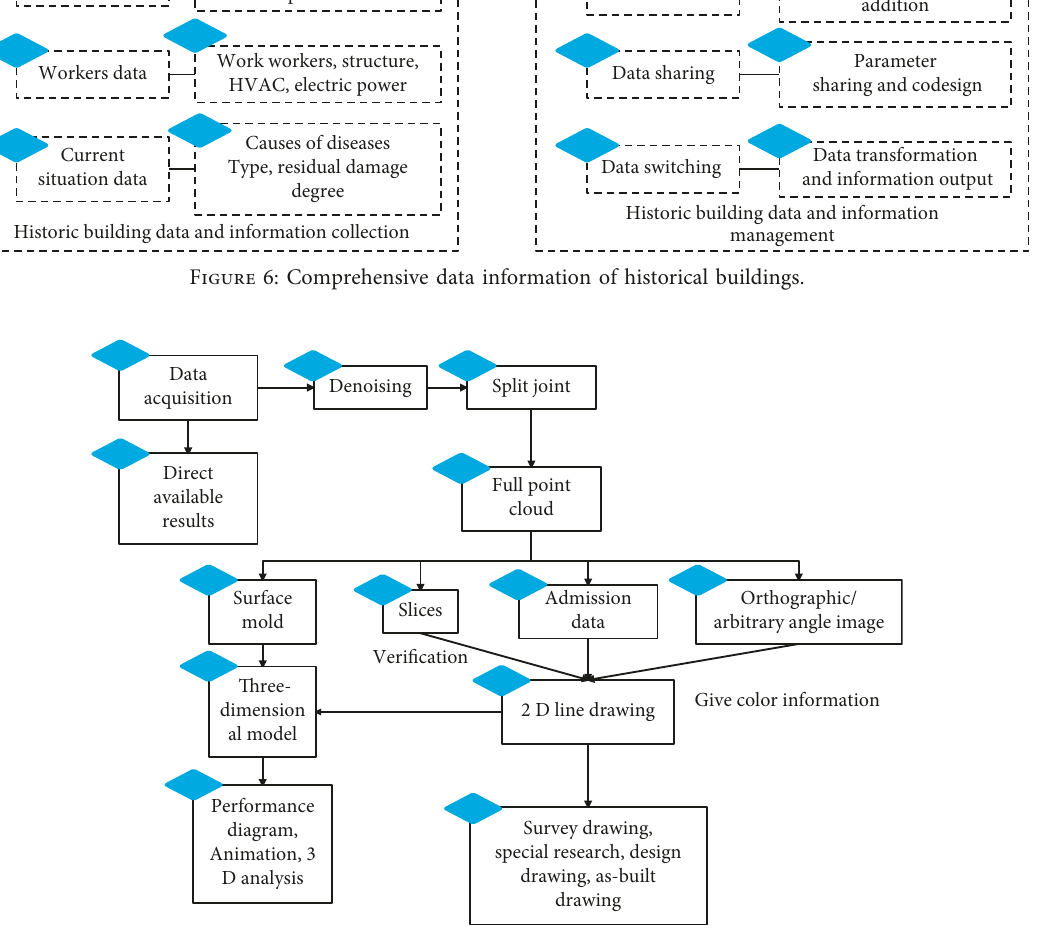
Figure 7: Process of building scanning data collection and